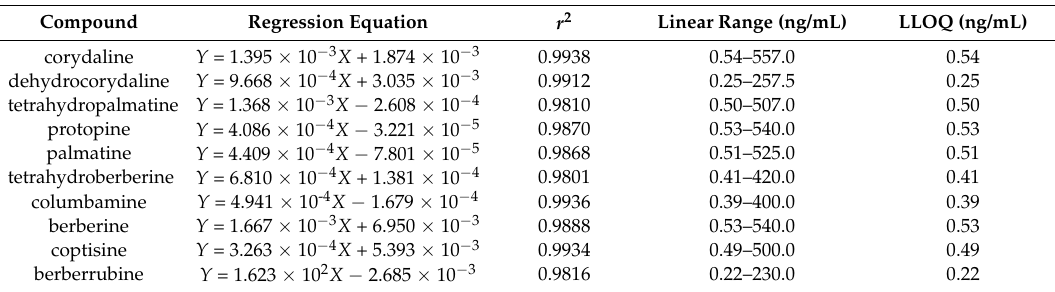
Table 1. The regression equations, linear ranges, and LLOQ for the determination of the alkaloids in the beagle dog plasma. ( n = 7).